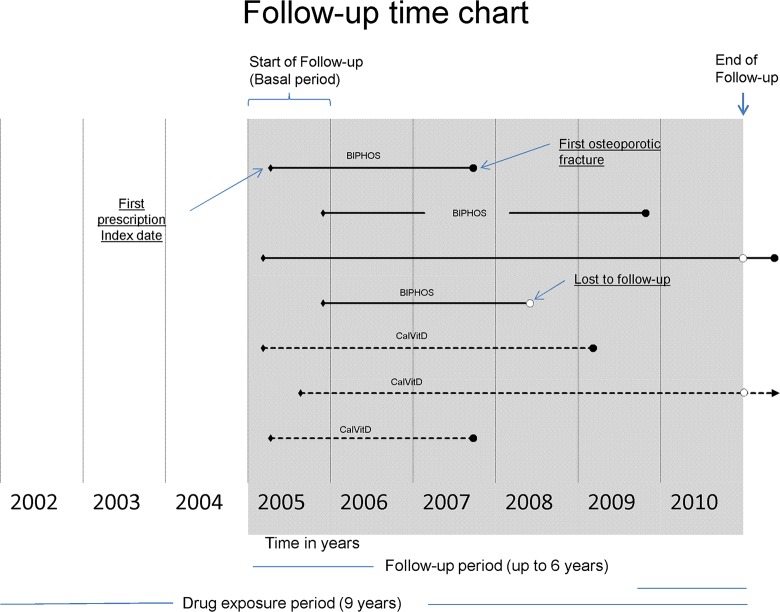
Follow-up time chart.